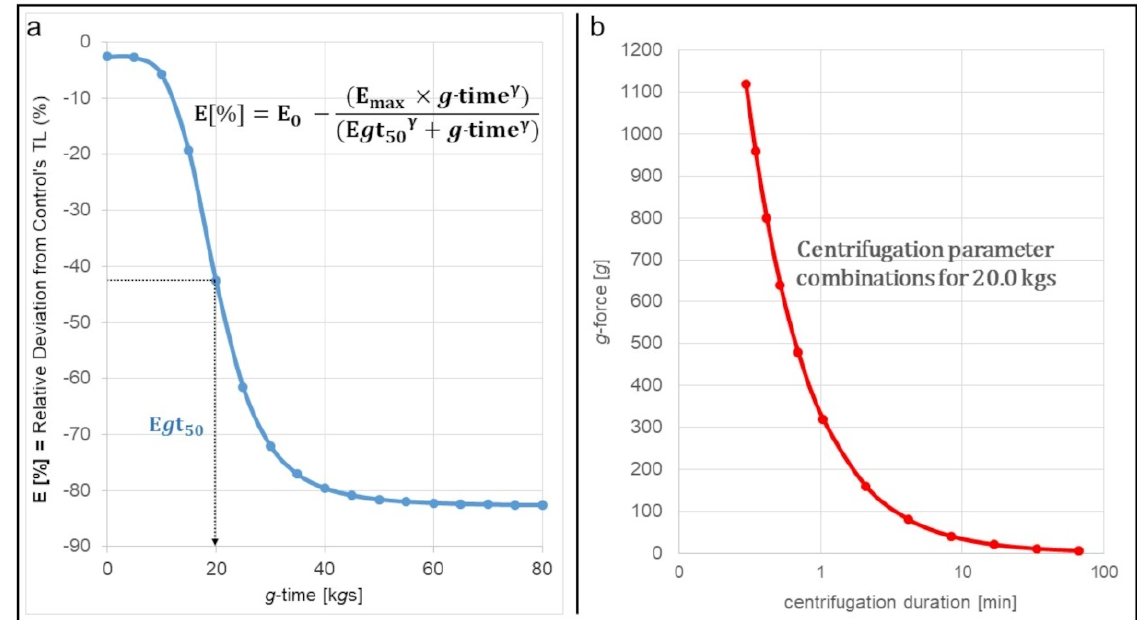
Figure 8. Graphical presentation of the correlation between g -time and relative deviation from control’s track length. ( a ) Inhibitory dose–response curve for the effect of g -time on neutrophil migration. “E” represents the effect size, in this case the rTL-value. “E 0 ” represents the initial level. “E max ” represents the maximum effect size. “E g t 50 ” indicates the g -time value, at which half of the maximum effect has been reached. ( b ) Possible combinations of centrifugation parameters to reach the E g t 50 value of 20.0 k g s.